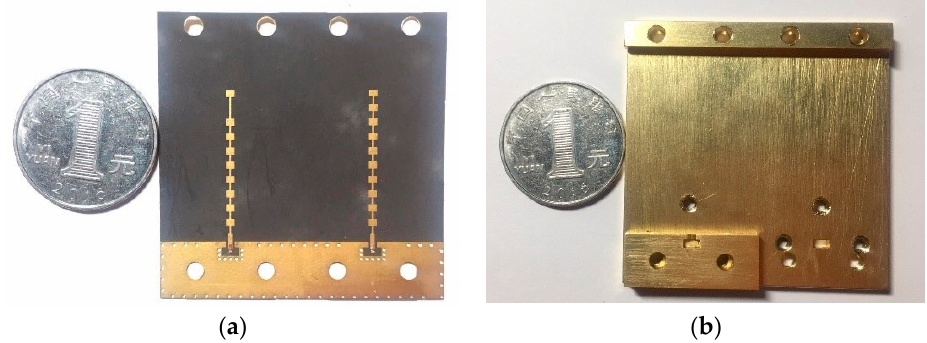
Figure 6. ( a ) The 77 GHz patch array antennas; ( b ) the copper components for measurement.